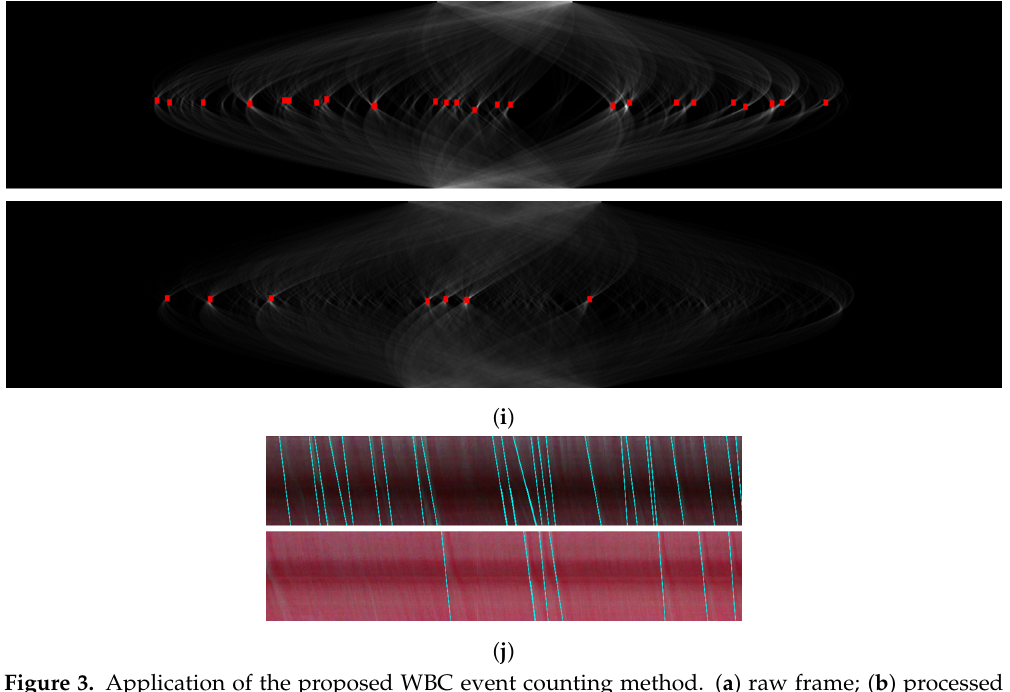
Figure 3. Application of the proposed WBC event counting method. ( a ) raw frame; ( b ) processed frame; ( c ) labels of capillaries; ( d ) coordinates of labels; ( e ) ST maps from capillaries; ( f ) processed ST maps; ( g ) polar maps obtained by applying Radon transform; ( h ) detected local maxima from ( g ); ( i ) local maxima selected as base events; ( j ) reconstructed lines according to events in ( i